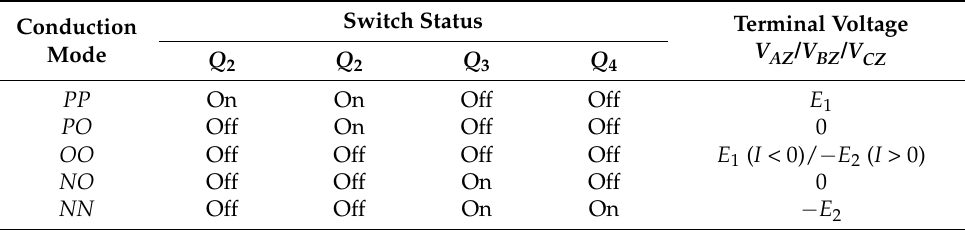
Table 2. Conduction mode.